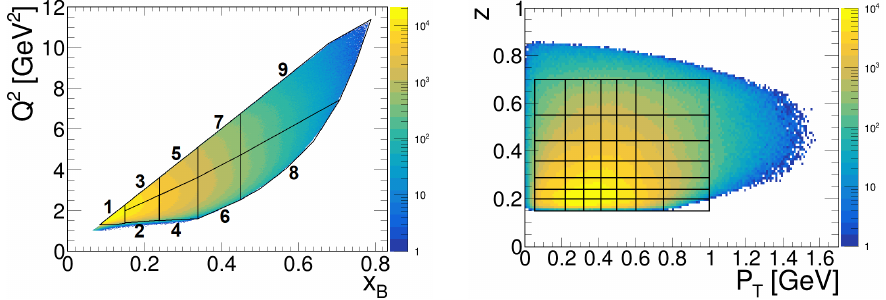
Figure 2: Left: Distribution of Q 2 versus x lines and the bin numbering is given. Right: Correlation between z and P x - bin 1. The black lines indicate the bin borders. [ 10 B